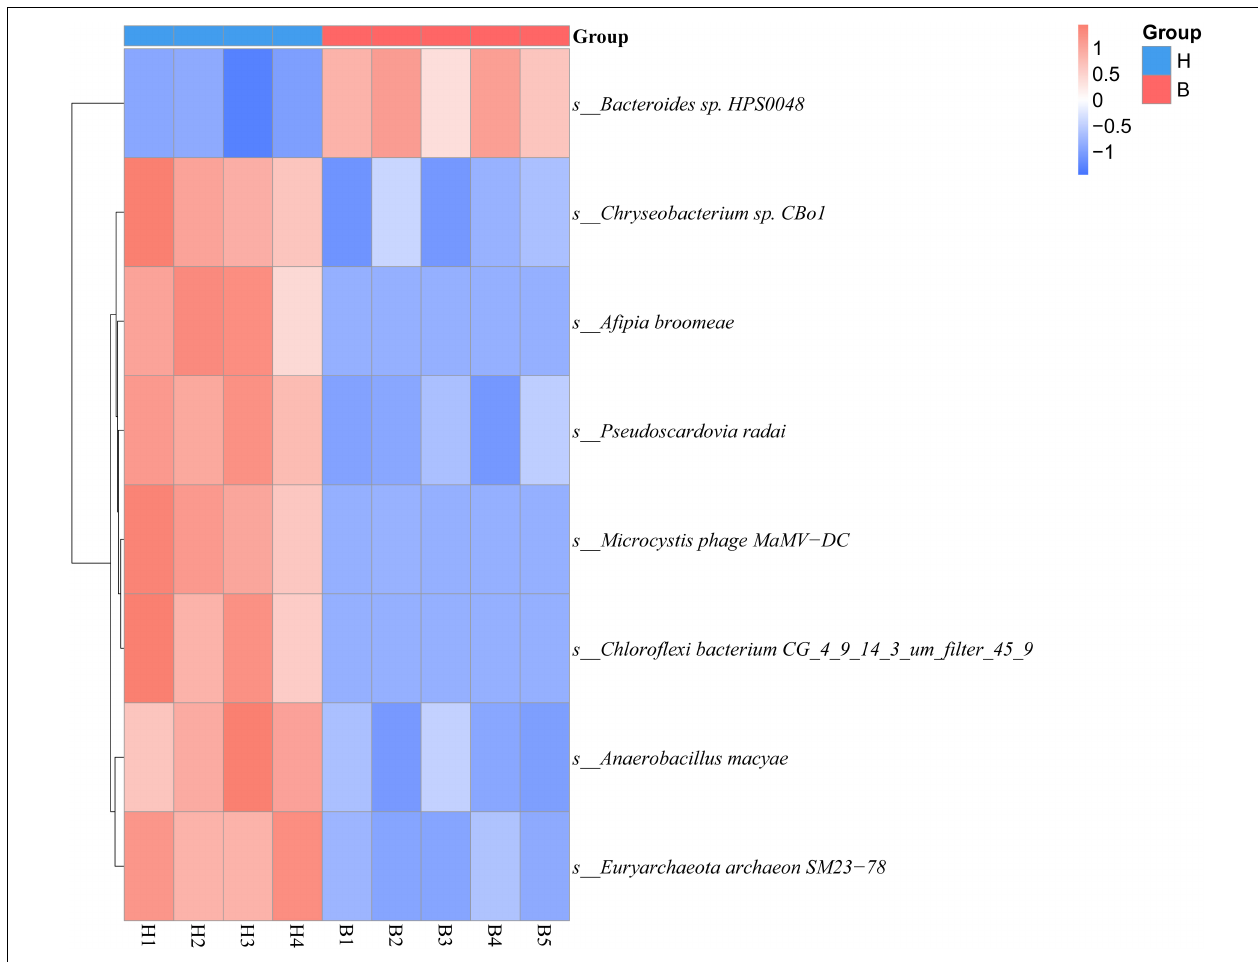
FIGURE 3 | The abundance clustering based on significant differences in species at the species level. The horizontal axis represents sample information; the vertical axis represents annotated information of species; the cluster tree on the left is the species cluster tree. The values corresponding to the intermediate heat map are the Z values of the relative abundance of each row of species after standardized treatment.